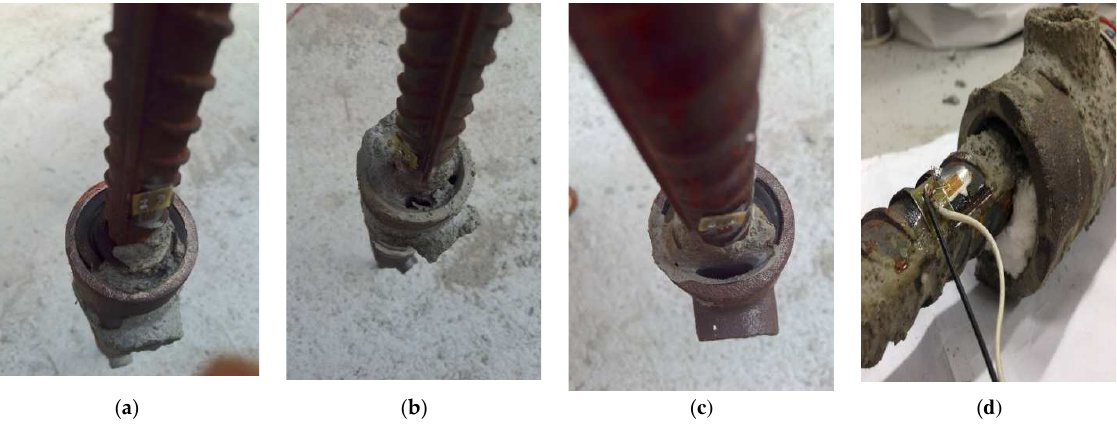
Figure 3. Schematic diagrams of different grout compactness. ( a ) 100% compactness. ( b ) 90% compactness. ( c ) 70% com- pactness. ( d ) 50% compactness.